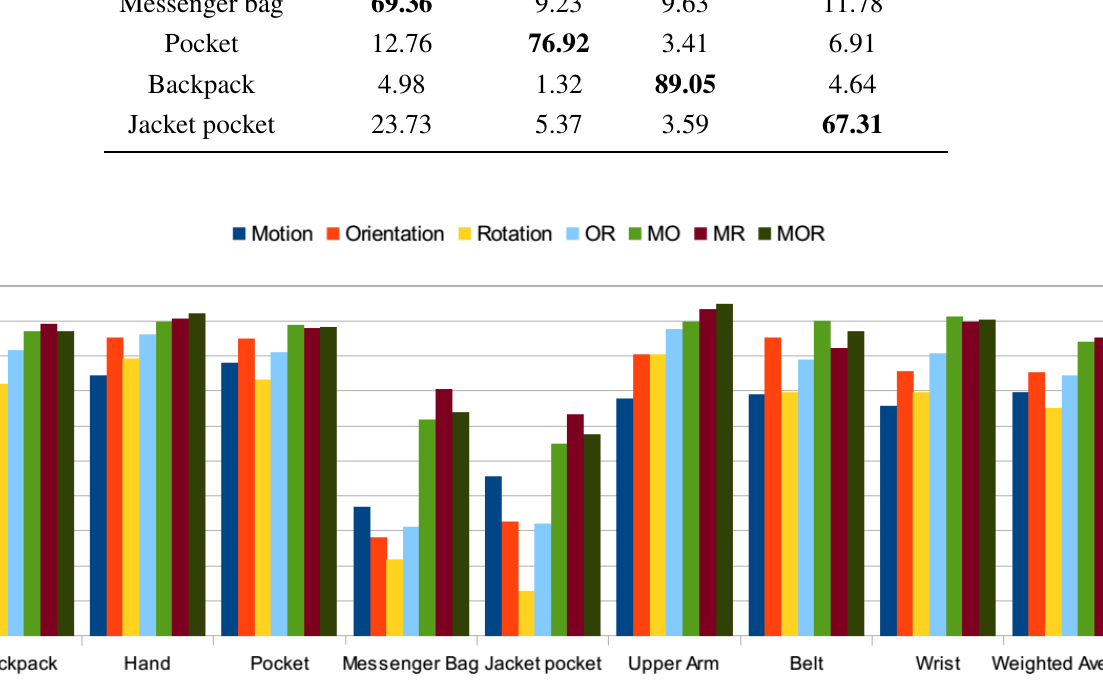
Figure 7. Different feature combinations (M: motion; O: orientation; R: